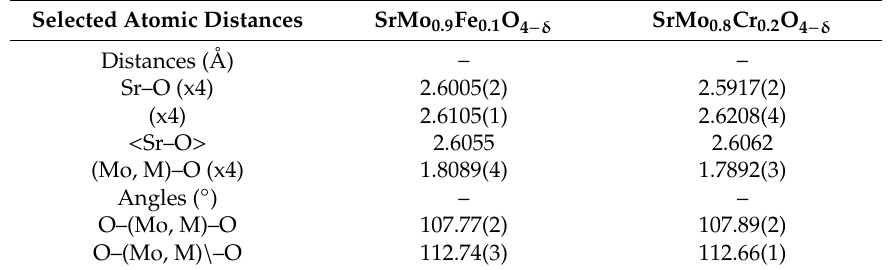
Table 2. Selected atomic distances (Å) and angles (deg) for SrMo 1 − x M x O 4 − δ from NPD at 25 ◦ C. Selected Atomic